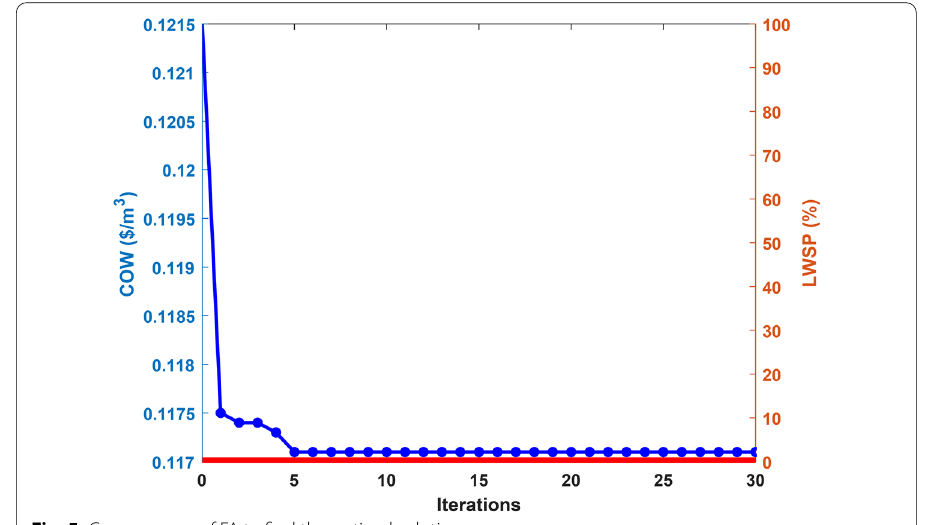
Fig. 5 Convergence of FA to find the optimal solution